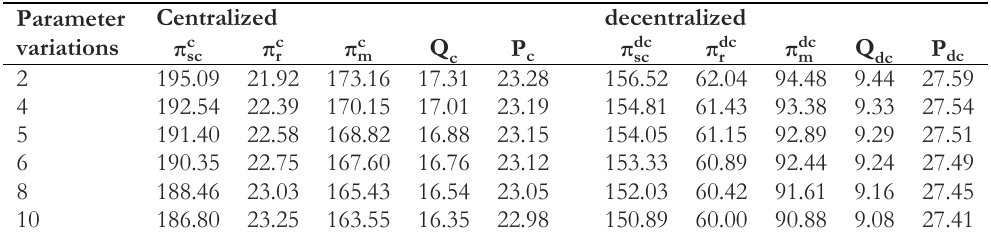
Table 3. Sensitivity analysis of the values of the objective functions for the maintenance cost parameter.